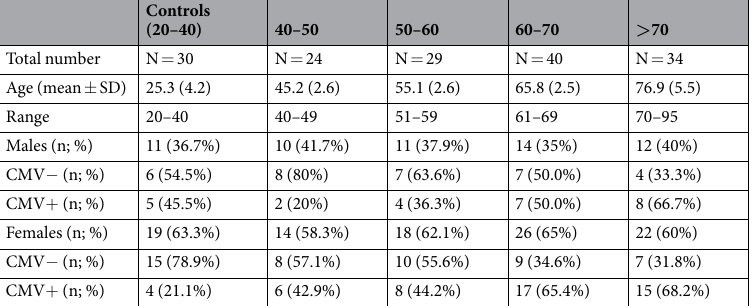
Table 1. Age group characteristics of study subjects. Values are means (SD) and absolute numbers (percentages). Percentages of CMV negative and positive individuals are from total males or